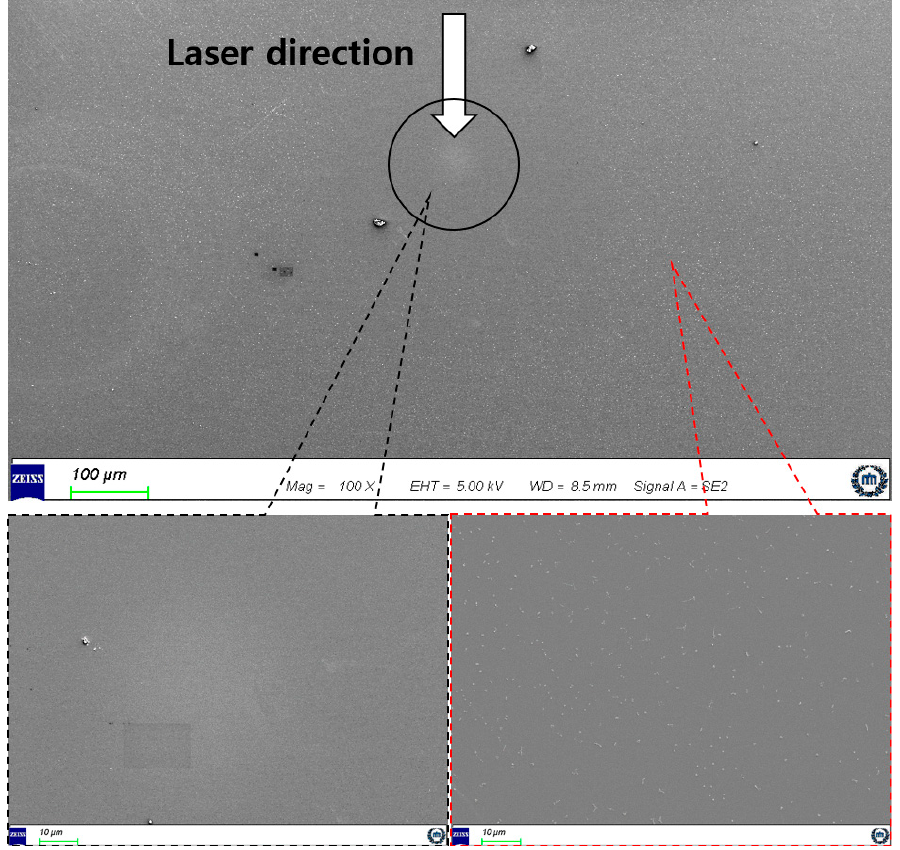
Figure 7. Photo of damage caused by thermal damage and laser ablation: black dotted line area magnification, EHT, WD, signal A is 500 × , 5.00 kV, 8.5 mm, SE2, respectively; red dotted line area magnification, EHT, WD, signal A is 1.00k × , 5.00 kV, 8.9 mm, SE2, respectively.